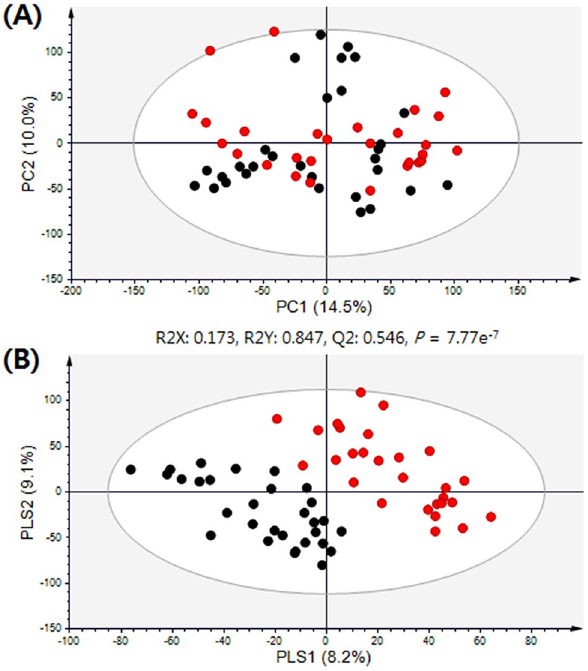
Figure 2. Principal component analysis (PCA) ( A ) and partial least squares discriminant analysis (PLS-DA) ( B ) score plots for candidate plasma markers in diabetic macular edema (DME) and non-DME subjects analyzed by GC–TOF–MS in discovery cohort. Black filled circle—non-DME group, red filled circle—DME